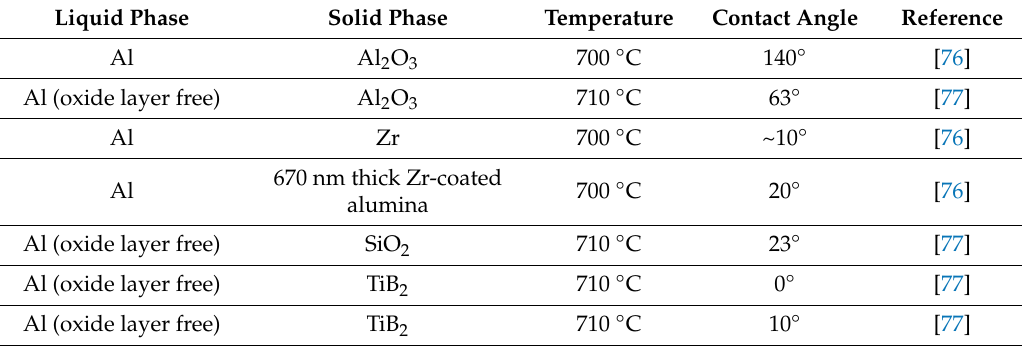
Table 1. The wettability of the di ff erent materials by molten metal